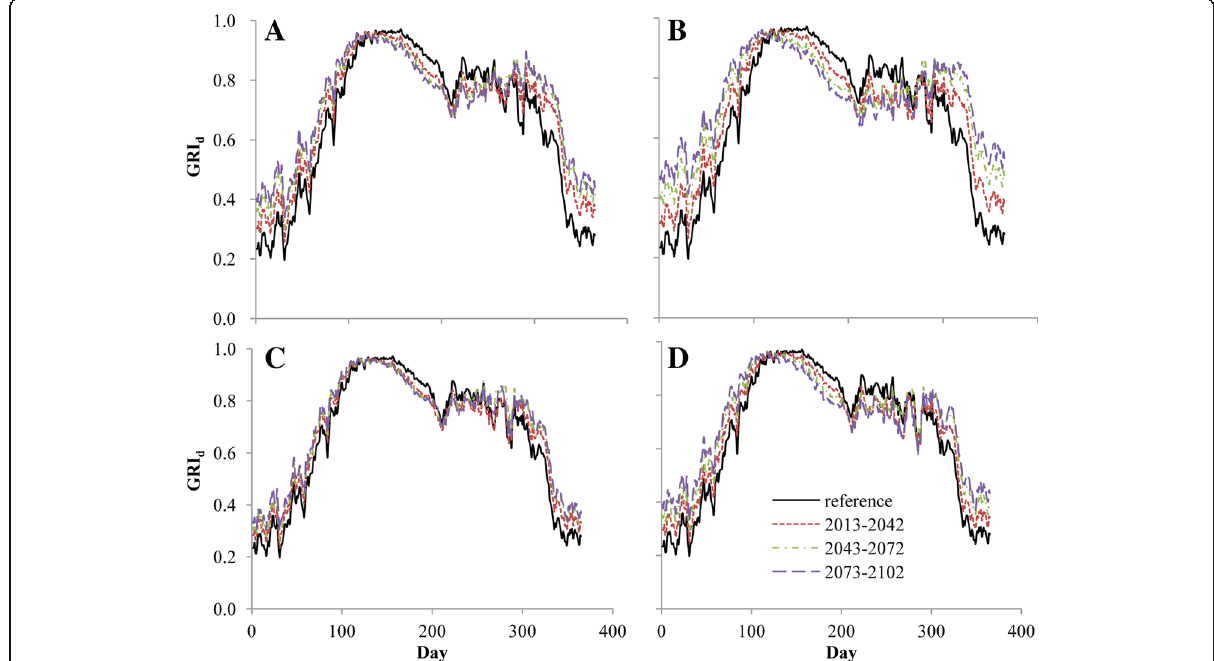
Fig. 8 Simulation results showing the average daily growth response index. Based on three 30-year future time periods (coinciding with each rotation) relative to the reference period for the a HG4.5 scenario, b HG8.5 scenario, c CNRM4.5 scenario and d CNRM8.5